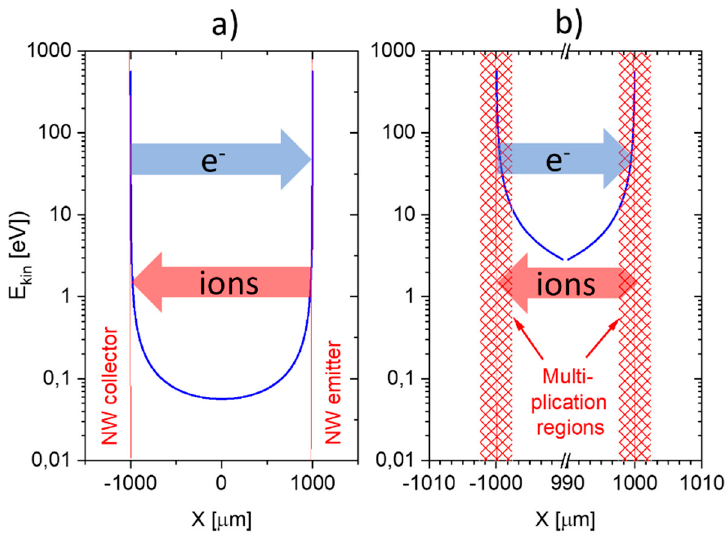
Figure 18. ( a ) Kinetic energy gained in between gas-kinetic collisions inside the electrode gap of an E-E device. The arrows indicate a flow of ions and a flow of electrons generated by positive ion impacts onto the collector electrode; ( b ) detailed view onto the air space immediately adjacent to the positive nanowire (NW) emitter and negative NW collector electrodes. The cross patterns indicate those regions in which positive ions emitted from the NW emitter can trigger avalanches of secondary ions.